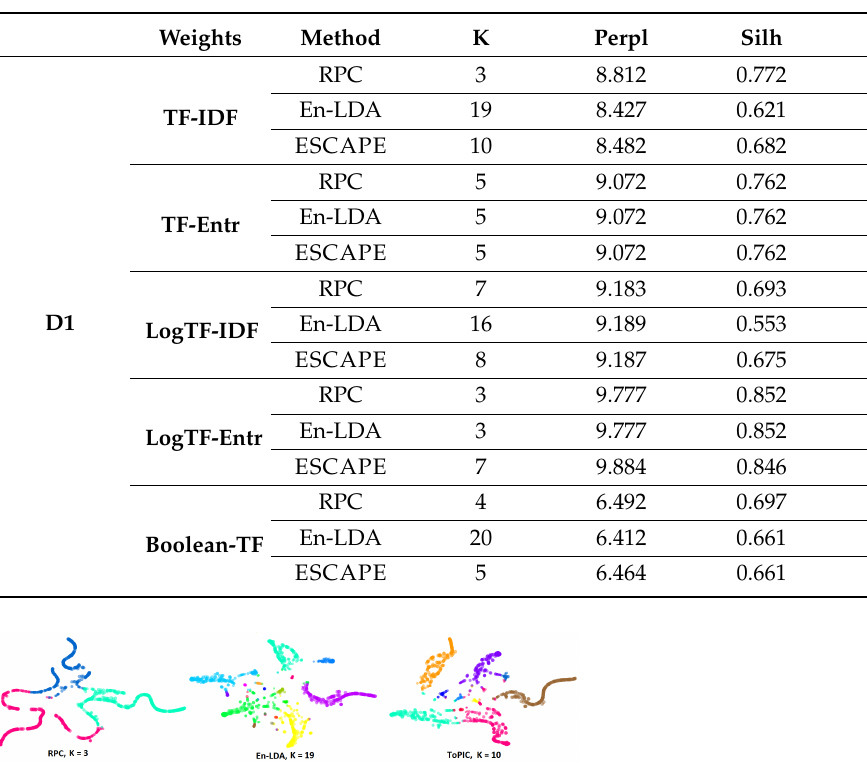
Table 15. Comparison between ESCAPE’s performance and that of other state-of-the-art methods.